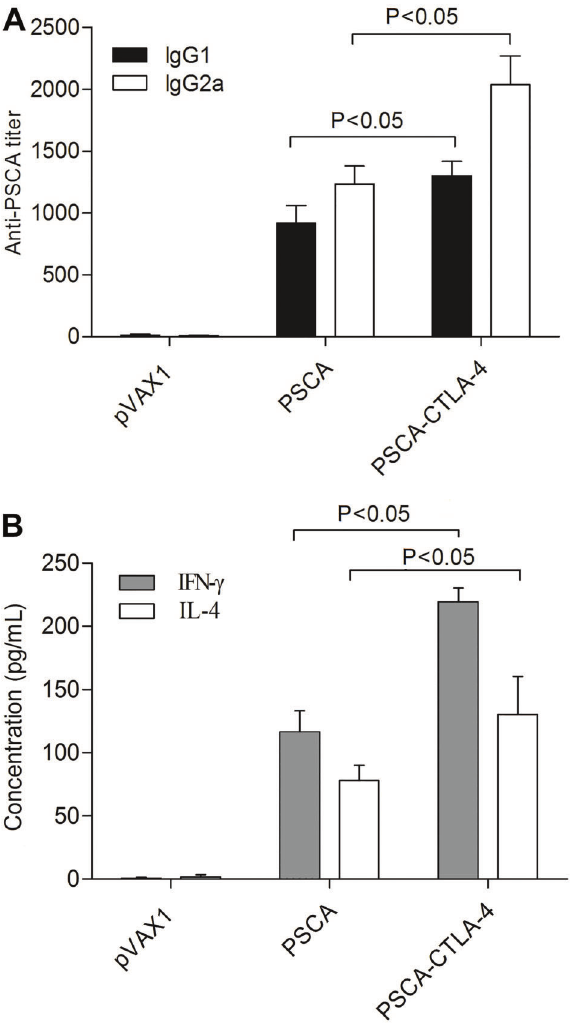
Figure 3. DNA vaccine induced antigen-speci fi c Th1 and Th2 immune responses analyzed in sera from mice at 2 weeks after the fi nal immunization. A , antibody subtype (IgG1 and IgG2a) responses. B , cytokine pro fi le of proliferating T cells. Data are reported as means ± SD